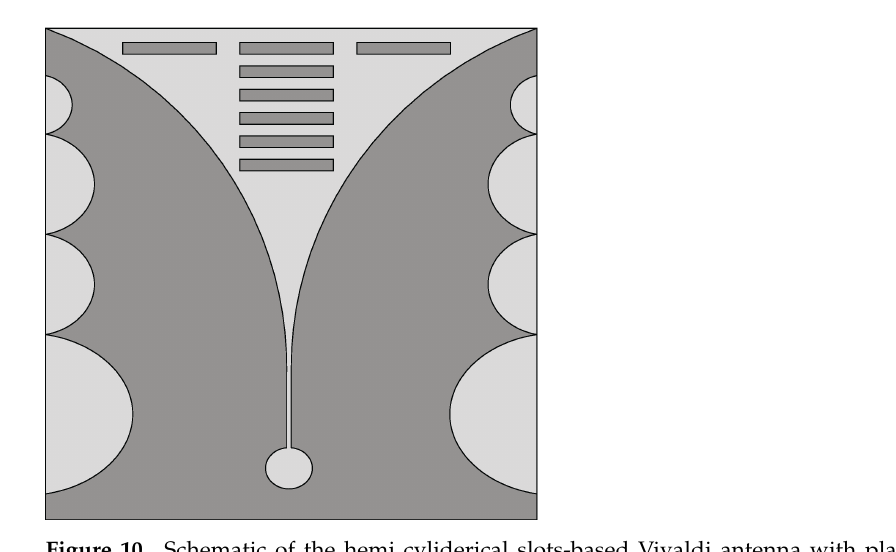
Figure 10. Schematic of the hemi cyliderical slots-based Vivaldi antenna with planar directors (redrawn from [61]). Medium gray bottom metal face and light gray dielectric substrate.